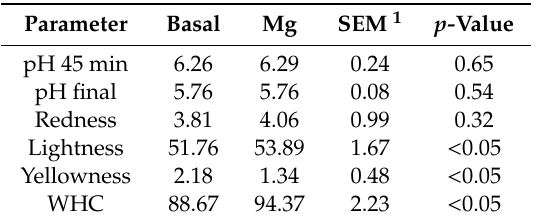
Table 5. E ff ect of the dietary treatment on general physicochemical parameters and water holding capacity (WHC, %) of breast muscle of experimental